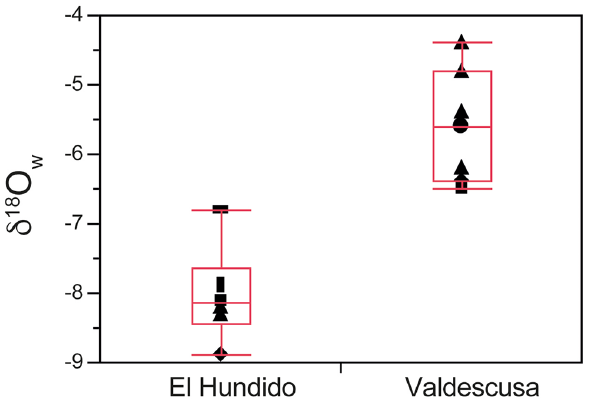
Figure 4. δ 18 O w values recorded in tooth enamel of individuals from El Hundido and Valdescusa sites.